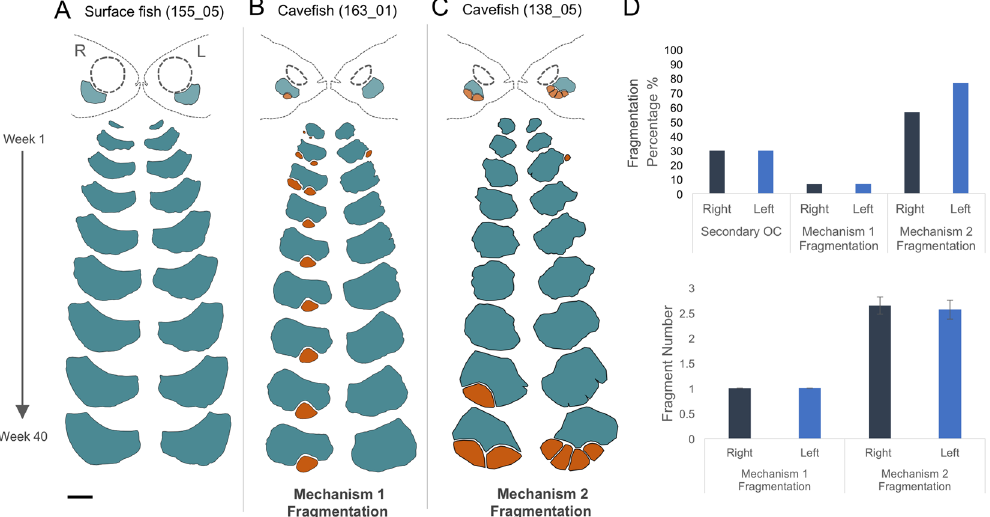
Figure 2. Astyanax cavefish exhibit lateral asymmetry in SO3 bone shape and fragmentation during ossification. Lateral ossification of the SO3 bones was observed over a 40-week period. Surface fish ( A ; individual 155_05) undergo symmetrical ossification, both in size and shape of the SO3 bone. Cavefish that display 2°OCs that persist into adulthood as fragments (mechanism 1; individual 163_01) made up 13.3% of the experimental population (n = 30 cavefish) and show lateral asymmetry in the number and positions of 2°OCs, as well as overall SO3 shape throughout ossification ( B ). The majority of the experimental cavefish (90%; n = 30) exhibited fragmentation via post-ossification bone remodeling or mechanism 2 ( C ; individual 138_05). The bone remodeling sites, as well as number and location of fragments, differ between the right and left sides of the face. The frequency of onset of 2°OCs (30%) and mechanism 1 fragmentation (6.67%) were equal on both sides of the face ( D ; n = 30). In mechanism 2, however, the right side (dark blue) of the face showed 56.7% of bone remodeling events while the frequency was higher on the left side (light blue) with 76.7% individuals exhibiting SO3 fragmentation due to post-ossification bone remodeling. There is an increase in the number of fragments for mechanism 2 fragmentation, which produces an average of 2.65 fragments on the right and 2.57 fragments on the left, compared to mechanism 1 fragmentation, which produces just 1 fragment on each side of the face ( D ). The scale bar represents 500 μ